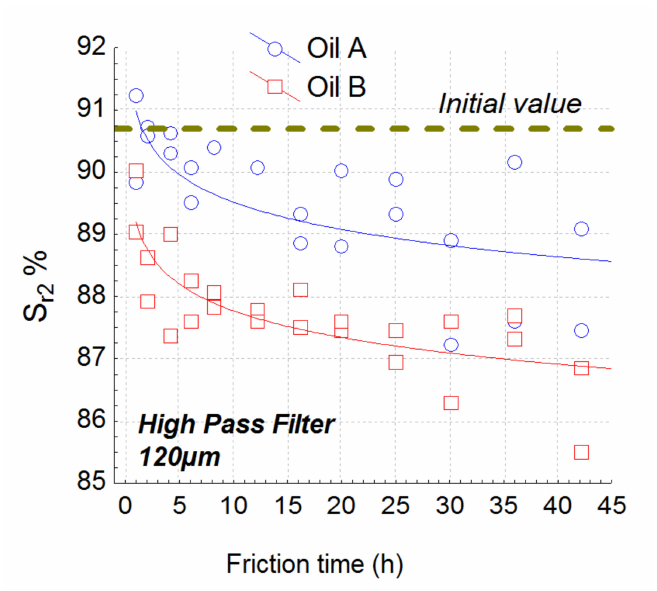
Figure 7. Plot of the most relevant parameters Sr 2 obtained by the global methodology. This parameter is computed with a high pass filter with a cut o ff of 120 µ m.